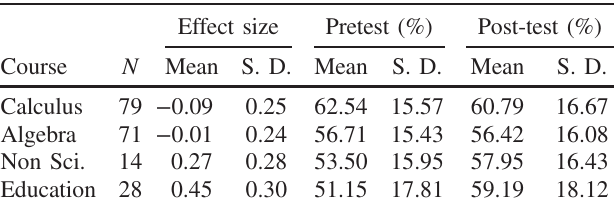
TABLE I. Descriptive statistics for the four types of introduc- tory physics courses: calculus-based courses, algebra-based courses, courses for future educators, and courses for nonscience